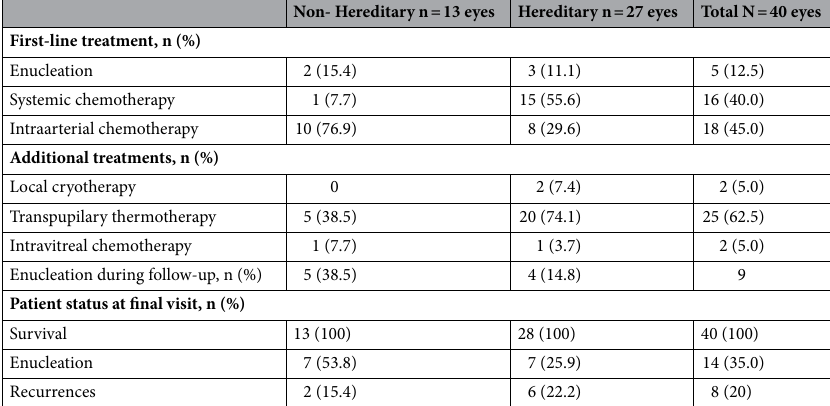
Non- Hereditary n = 13 eyes Hereditary n = 27 eyes Total N = 40 eyes First-line treatment, n